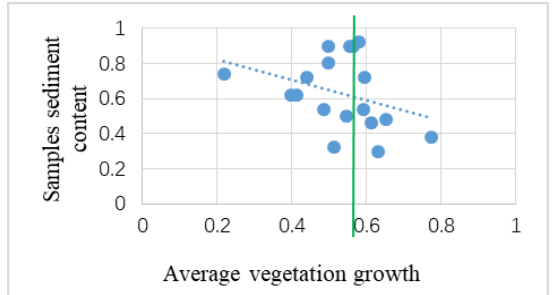
Figure 3. Regression analysis of sample sediment content and average vegetation